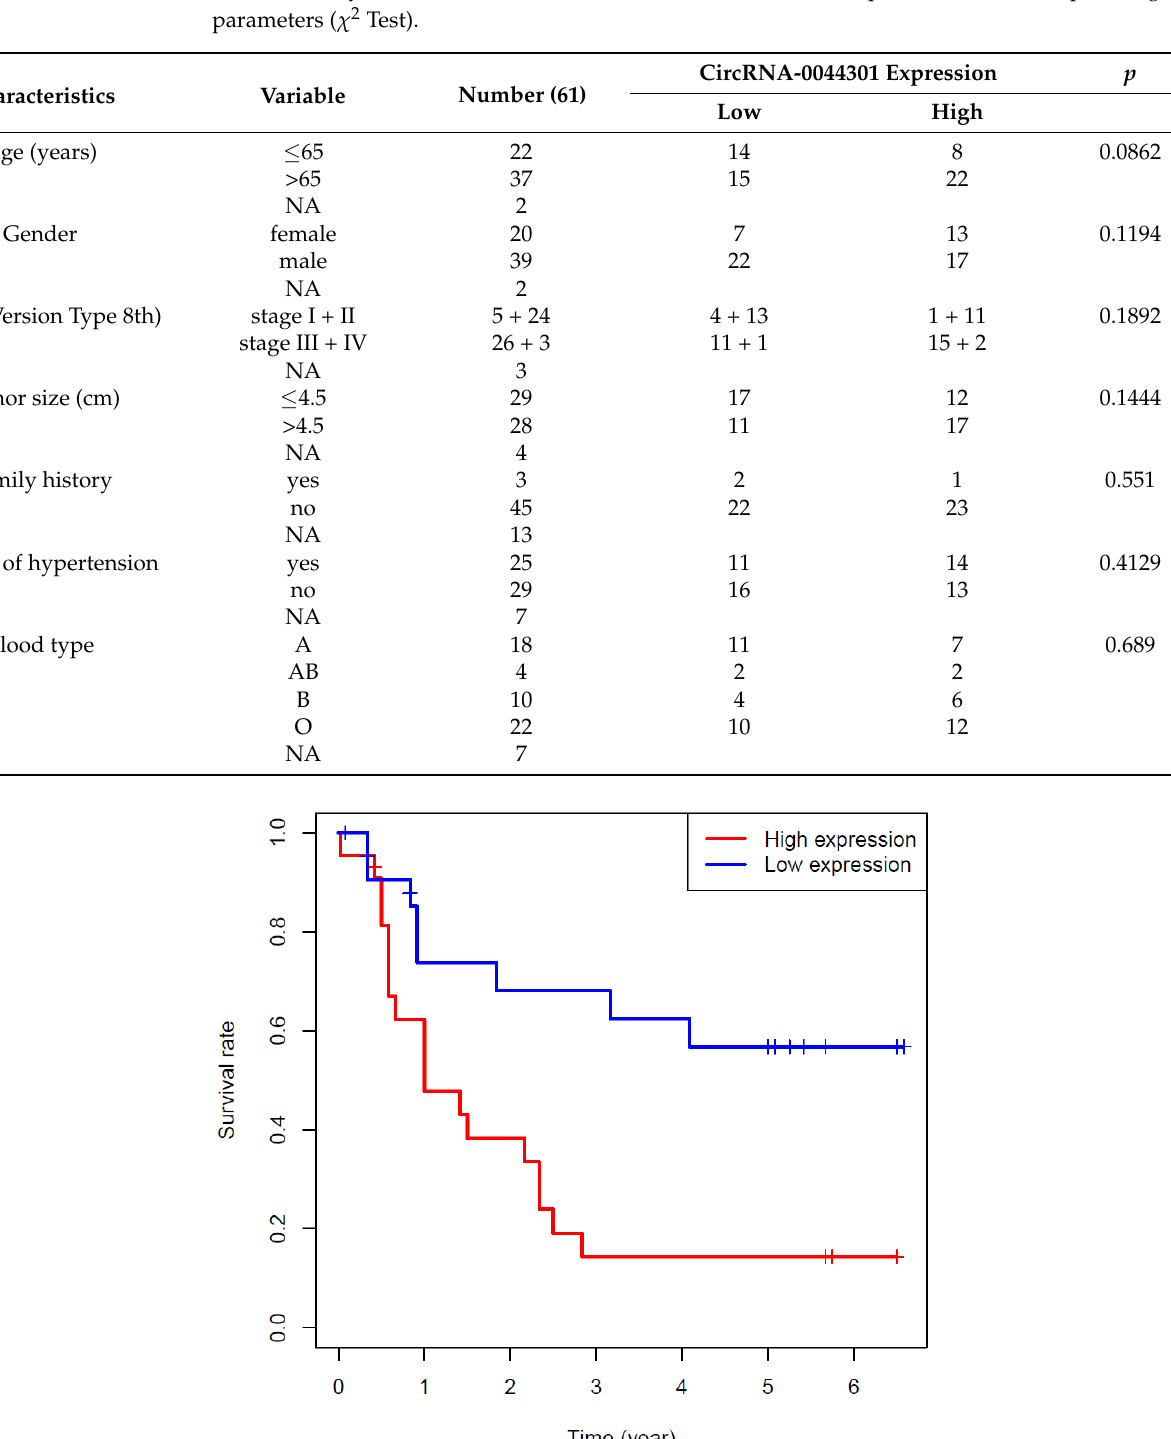
Figure 4. Survival curve of GC patients in the high- and low circRNA-0044301 expression groups showed that high circRNA-0044301 expression level was significantly associated with a poor prognosis of GC patients ( p = 0.006). Table 2. Independent prognosis analysis of clinicopathological parameters and circRNA-0044301.